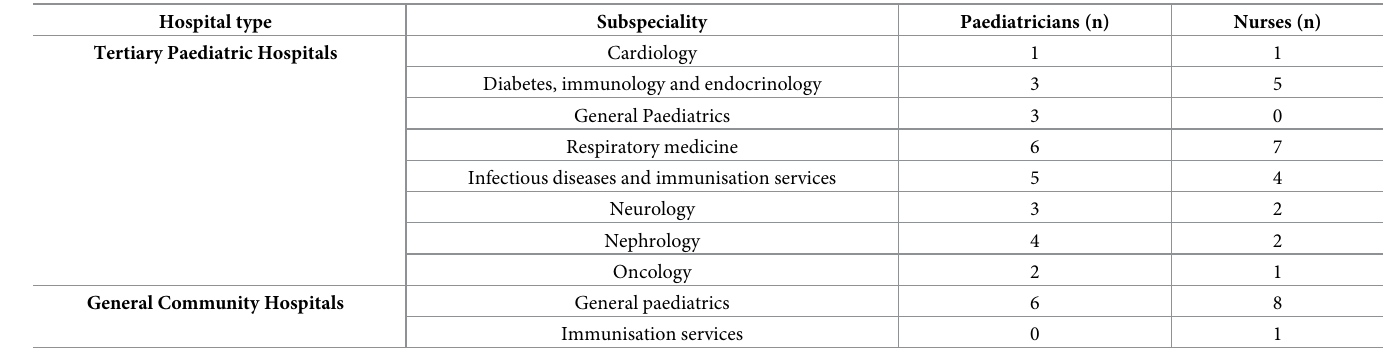
Table 1. Paediatricians and nurses participating in group discussions and in-depth interviews.